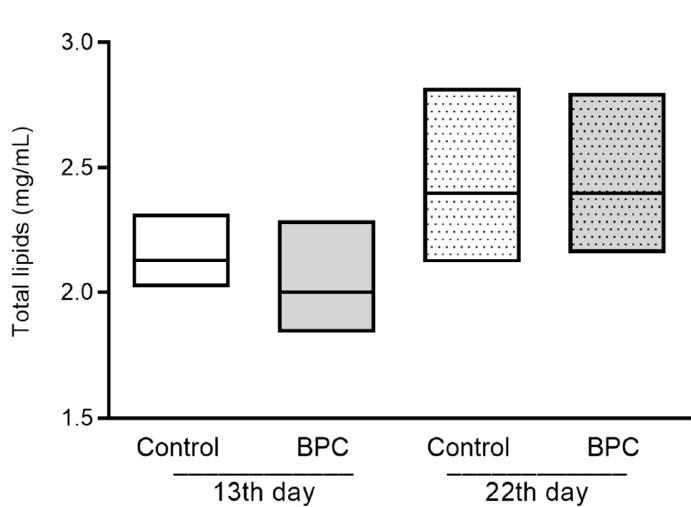
Figure 5. Total lipid concentrations in adult honeybee hemolymph sampled on the 13th and 22nd day of the experiment under laboratory-controlled conditions for the experimental BPC and control groups. No statistically significant differences for BPC vs. control were found.